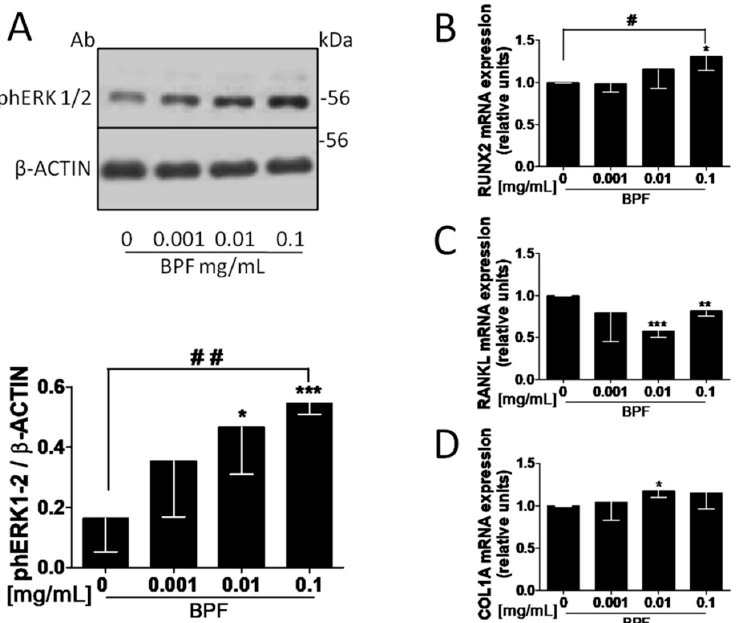
Figure 2. BPF increases phERK 1/2 protein levels and regulates RUNX2, RANKL and COL1A mRNA expression levels on Saos-2 cells. ( A ) Semi-confluent cultures of human osteoblast-like cells (Saos-2) incubated with BPF 0.001-0.01-0.1 mg/mL for 10 min. Cell proteins were analyzed by Western blotting with antibodies specific to phosphorylated ERK1/2 and β -actin. Semi-confluent cultures of human osteoblast-like cells (Saos-2) were incubated with BPF 0.001-0.01-0.1 mg/mL for 24 h. Then, mRNA expression levels of ( B ) RUNX2, ( C ) RANKL and ( D ) COL1A were measured by RT-Pcr. Data were analyzed using the 2 −ΔΔ Cq method and normalized to β -actin. Data are represented as mean ± SD. Statistical analysis: Student’s t -test vs. 0 * p < 0.05; ** p < 0.01; *** p < 0.001; Linear regression # p < 0.05; ## p < 0.01. Abbreviations: BPF, Bergamot Polyphenol Fraction; RUNX2, Runt-related transcription factor 2; RANKL, Receptor Activator of Nuclear factor- κ B Ligand; COL1A, Type 1A collagen.